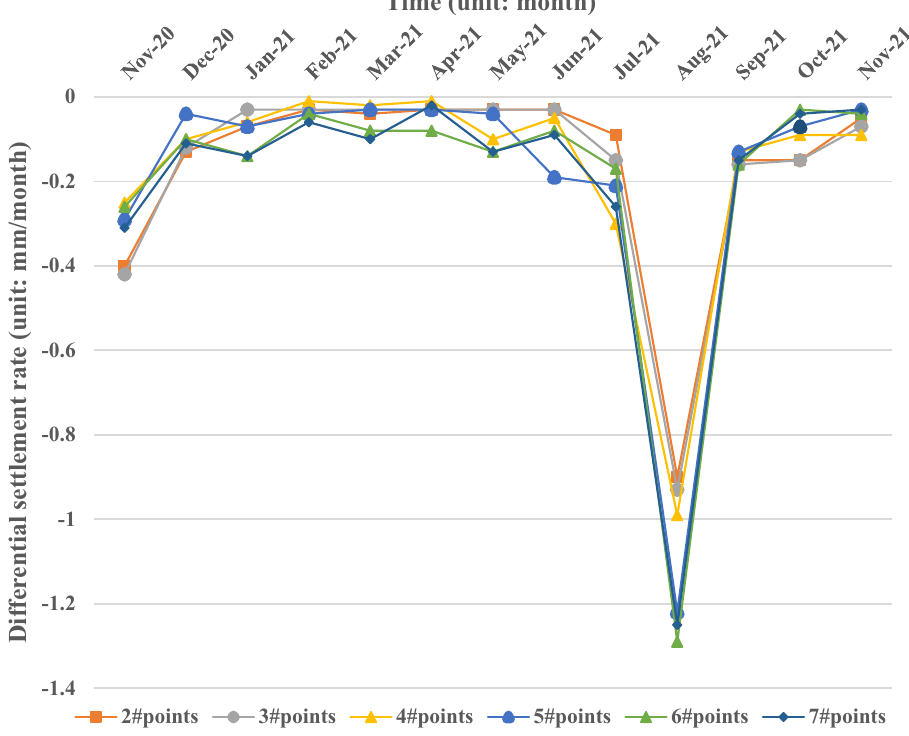
Figure 6. Cumulative differential settlement and settlement rate change diagram of monitoring